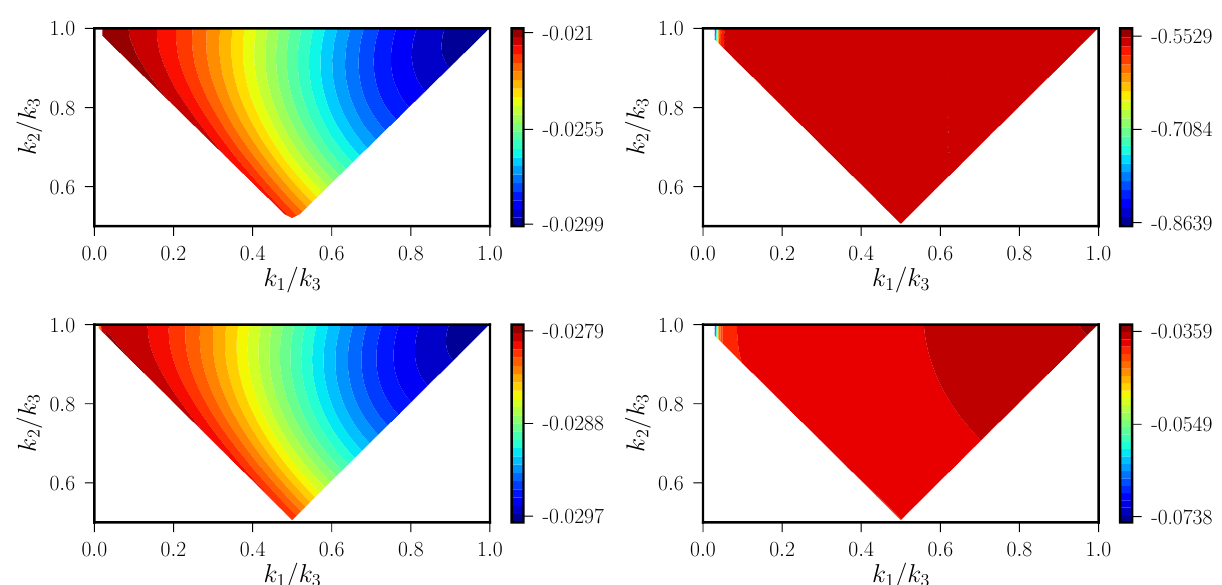
( k 1 , k 2 , k 3 ) has been presented NL (i.e., the pivot scale, on the left) or ∗ (i.e., over the ∗